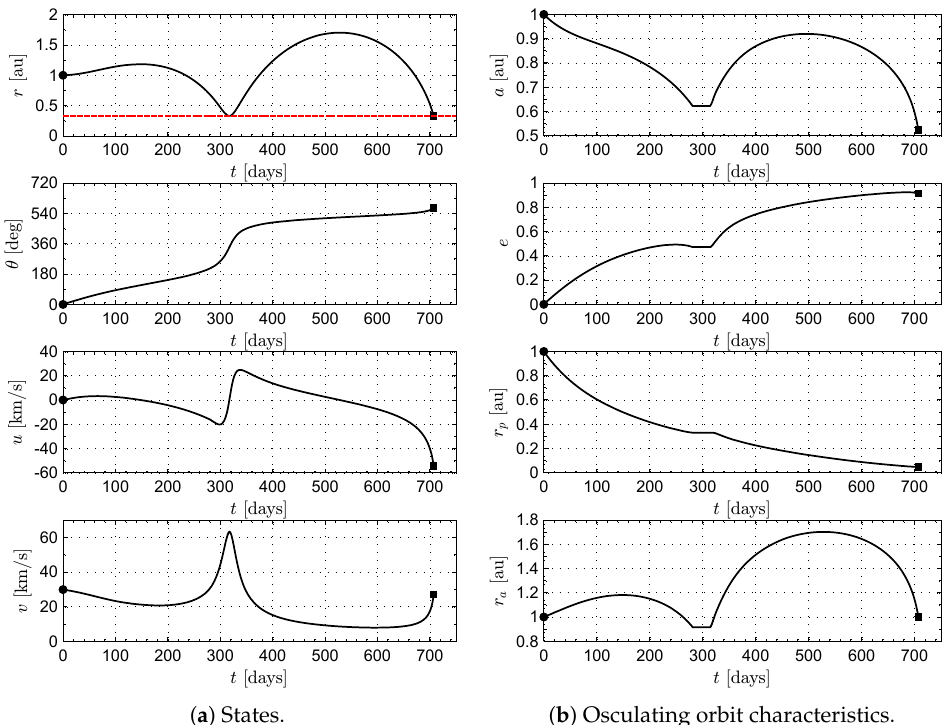
Figure 6. Time histories of spacecraft states and osculating orbit characteristics when a c = 1.5mm/s 2 . Black circle → starting point; black square → arrival point.